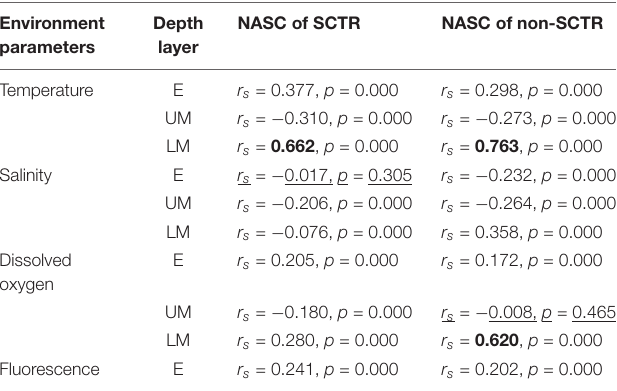
TABLE 4 | The Spearman rank-order correlation between the NASC and the environmental parameters by the depth layer in the SCTR and non-SCTR. Environment Depth parameters